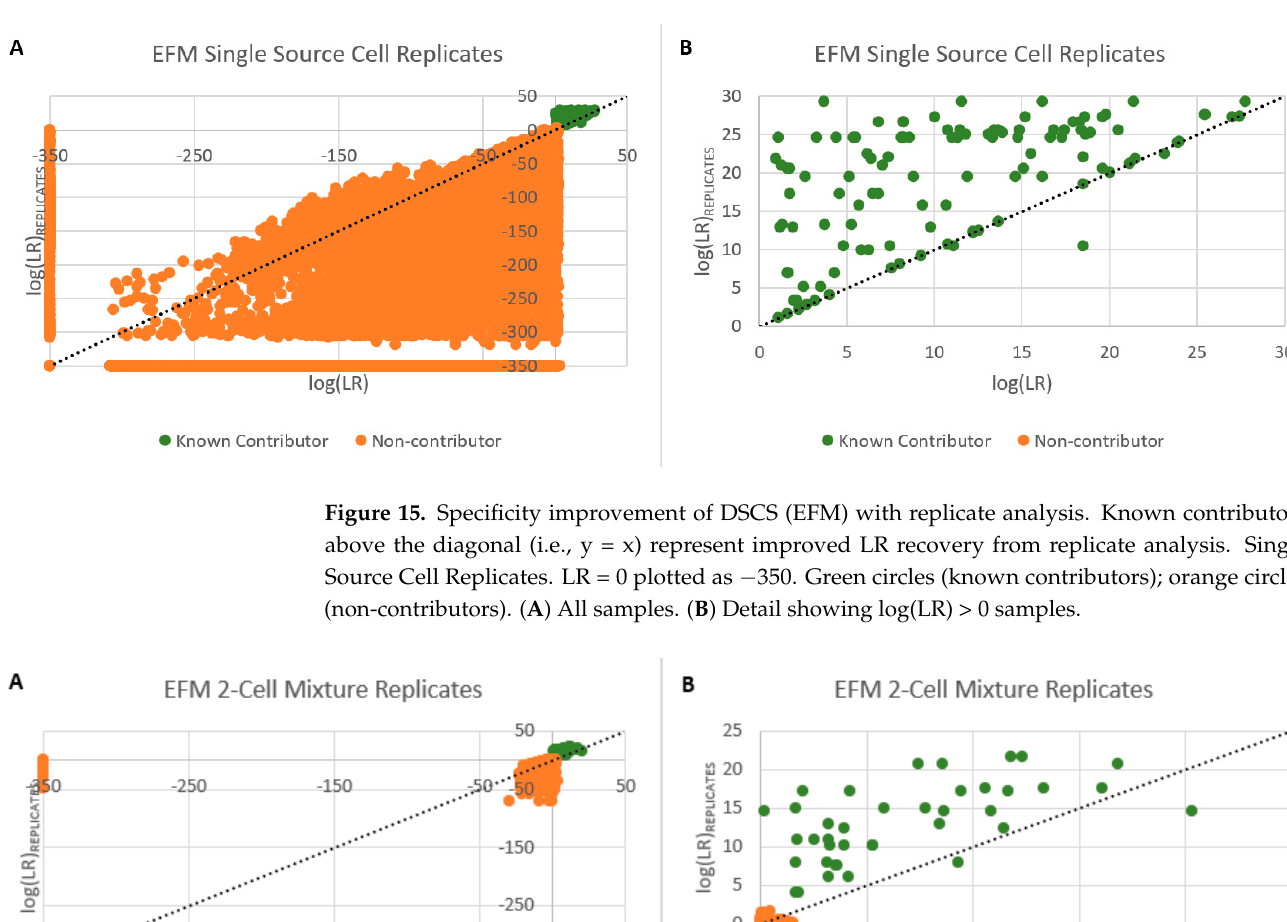
− 101 Table 6. Misclassification of mini-mixtures for replicate analysis. Correct Profiles S5/CM31 Mini-Mixture FAIL * * Note: FAIL refers to model validation failure likely due to an unintuitive NOC being utilized. 3.12. DSCS Deconvolution Compared to Standard Bulk Analysis In a single mixture, the DSCS procedure produces up to six different subsample types with associated LRs from separate putative contributors. These subsample types include one- and two-cell subsamples, two-cell mini-mixture subsamples, one- and two-cell rep- licates, and mini-mixture replicates. After replicate analysis, the maximum replicate like- lihood ratio obtained is reported. Seven equimolar complex mixtures were deconvoluted using this DSCS process. Figures 16–18 (EFM) compare the ‘ground-truth’ or maximum possible log(LR) per known donor (i.e., log(1/RMP) from single source reference profiles